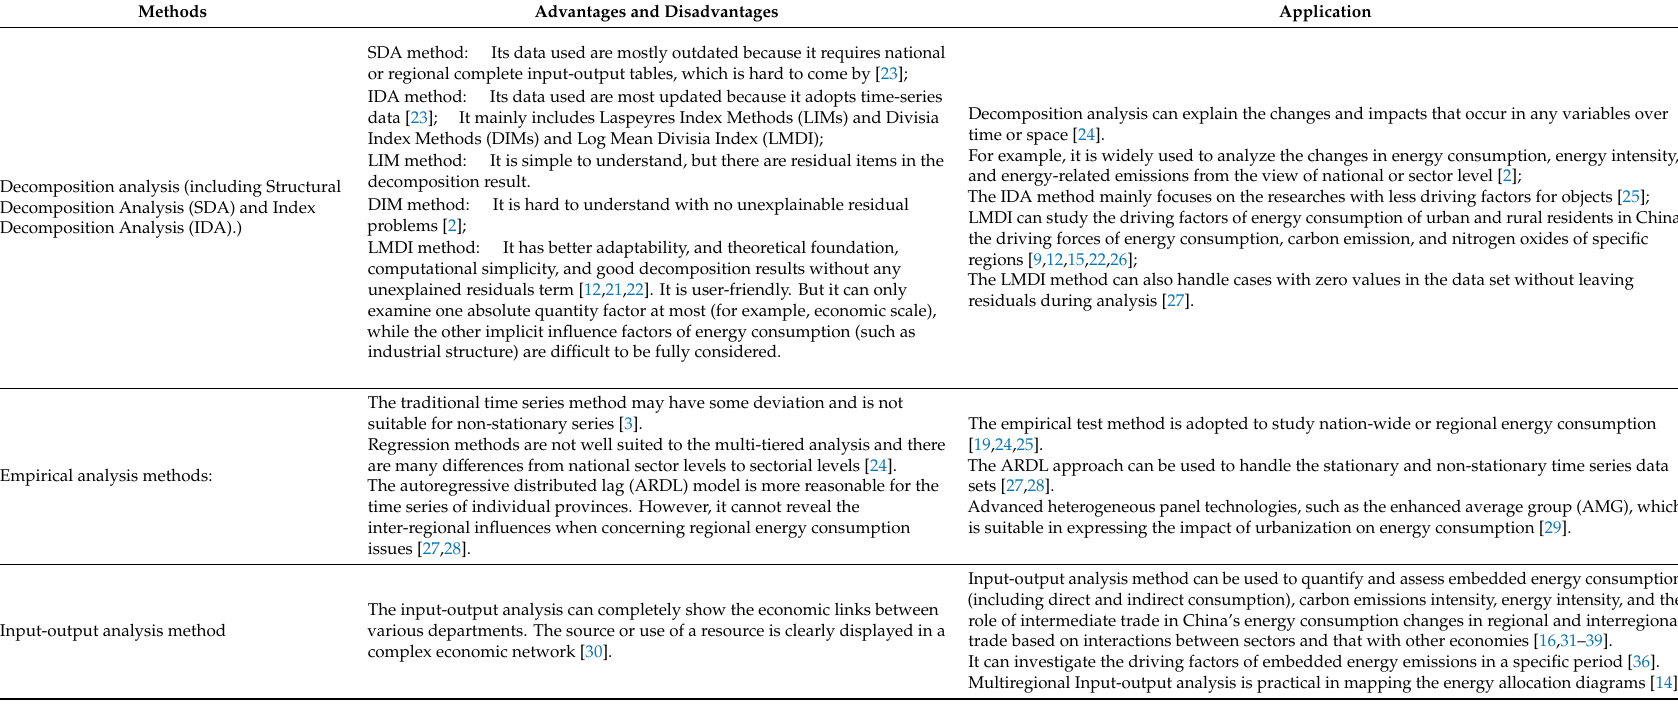
Table A2. Comparison of methods used to study energy